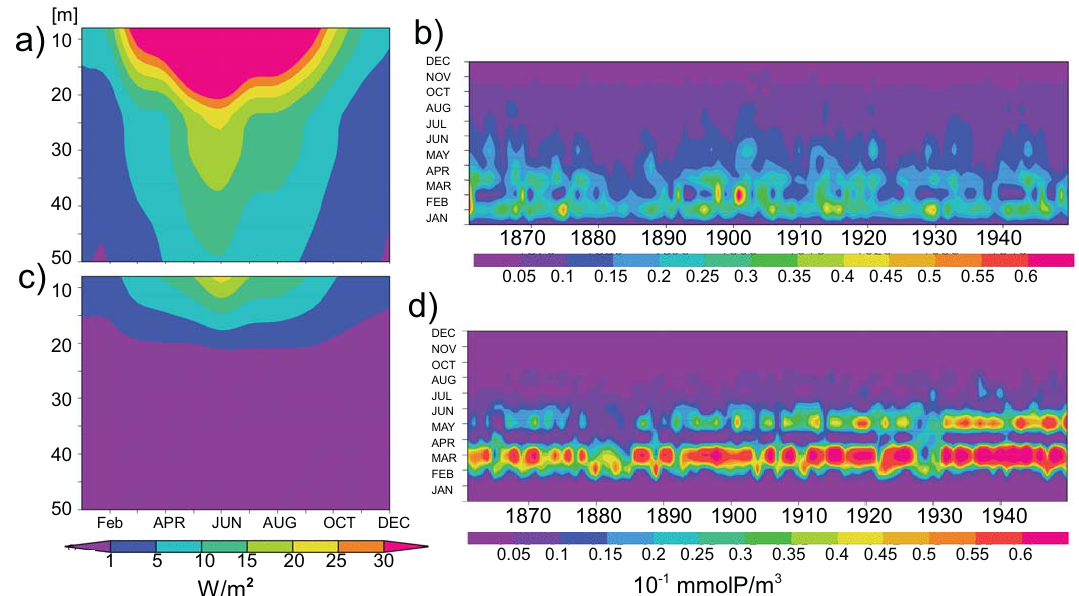
Fig. 11. (a) Available photosynthetic active short-wave radiation averaged over the North Sea south of 54 ◦ N using standard light scheme. (b) Seasonal cycles of phytoplankton (in P units) concentration using standard light scheme. (c) and (d) same as (a) and (b) but using modified light